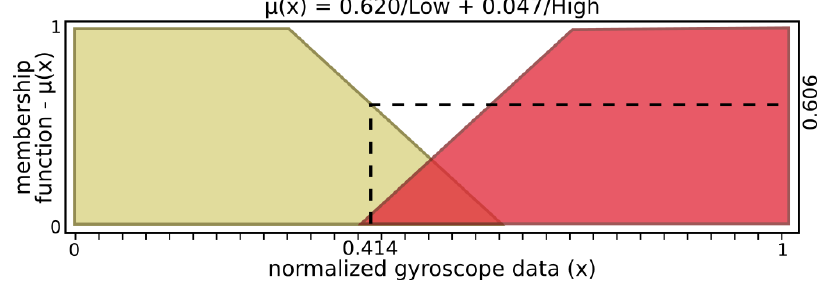
Figure 5. Input sets of